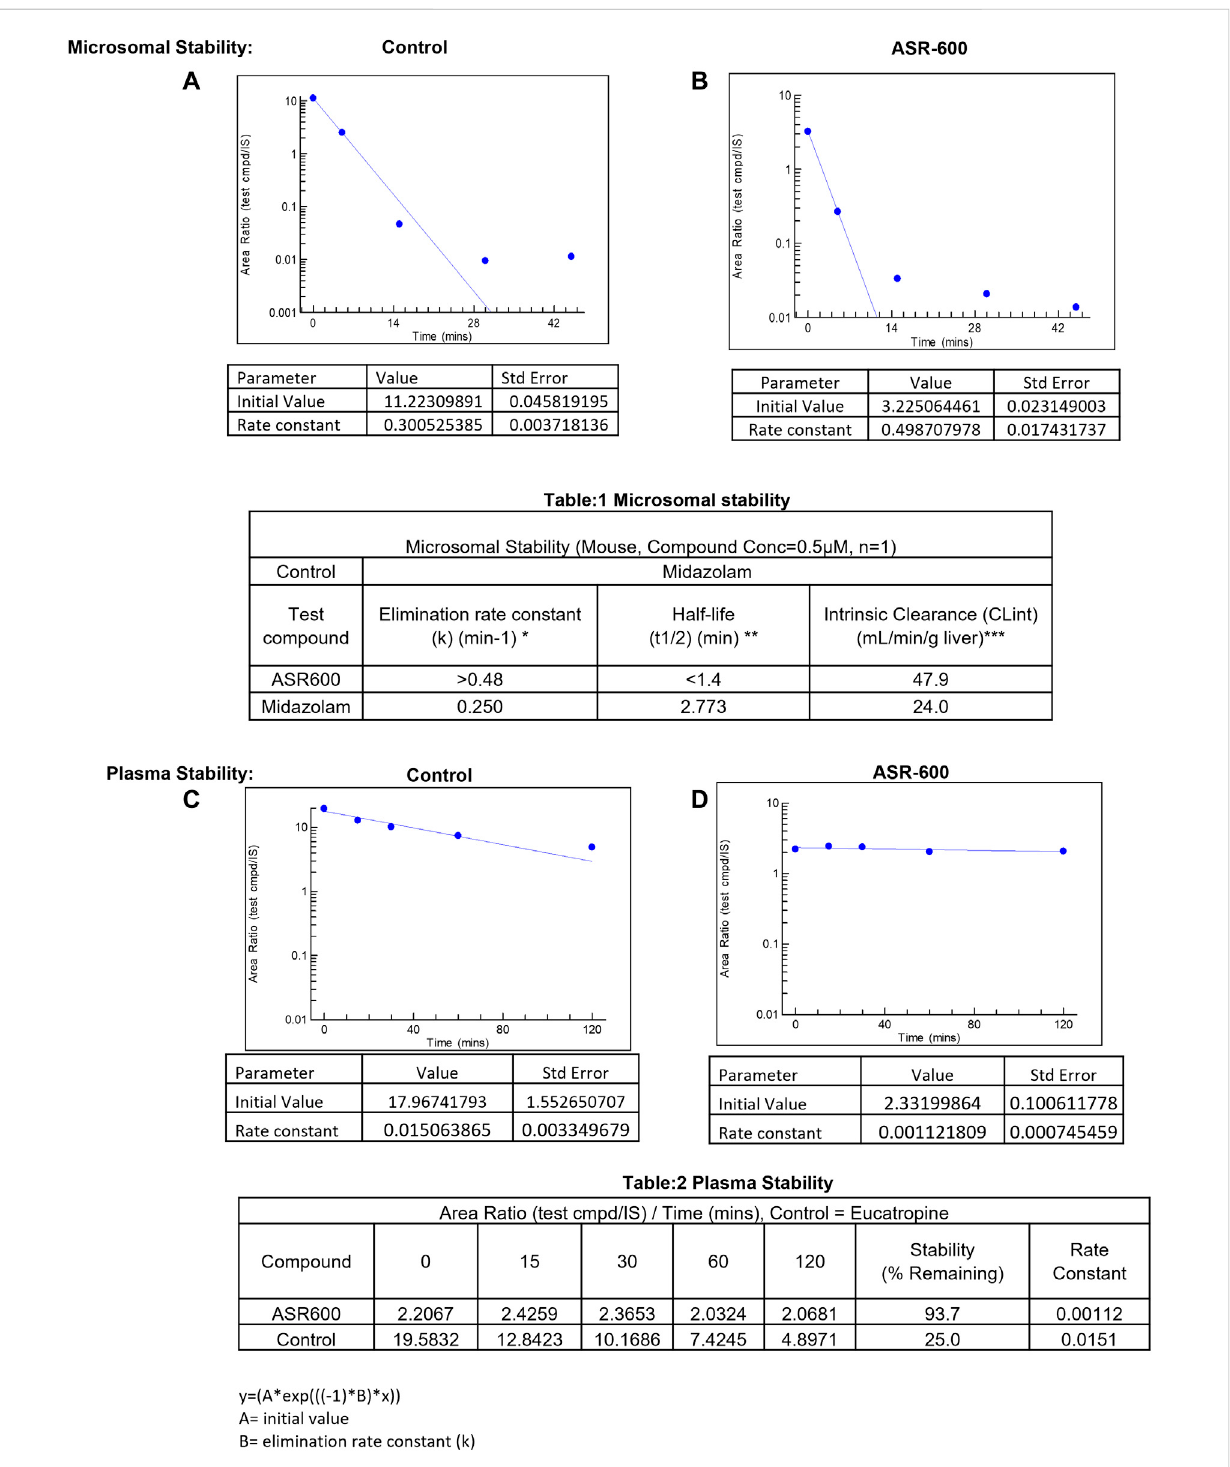
FIGURE 8 Microsomal and plasma stability ASR-600. Mouse microsomes were thawed and mixed with ASR-600 or control (Midazolam) (A) . ASR-600 and microsomes were incubated with or without cofactor (+NADPH) for indicated time points and plotted against area ratio. (B) . The area ratio was plotted against indicated time points for Midazolam (Table:1) Mouse microsomal stability. The elimination rate constant, half-life and intrinsic clearance of ASR- 600 and control: Midazolam. Mouse plasma was mixed with ASR-600 or control (Eucatropine) (C) . ASR-600 and mouse plasma were incubated for indicated time points and analyzed with LC-MS/MS. (D) . The area ratio was plotted against indicated time points for Midazolam (Table:2) Plasma stability. Stability and rate constant of ASR-600 and control: